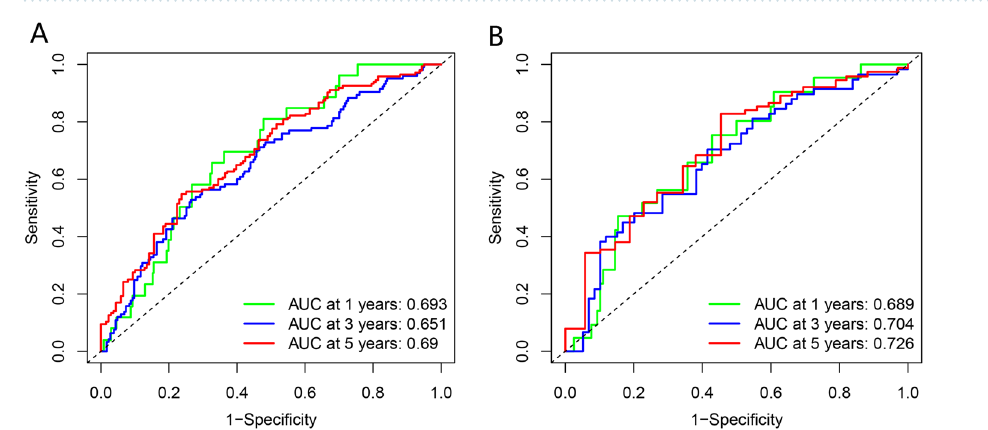
Figure 4. Validation of the prognostic, predictive power of four selected m 7 GMRRGs. ( A ) ROC curves of prognostic prediction models in the training set. ( B ) Validation of the ROC curves of the pooled prognostic prediction model. m 7 GMRRGs N7-methylguanosine methylation-related regulator